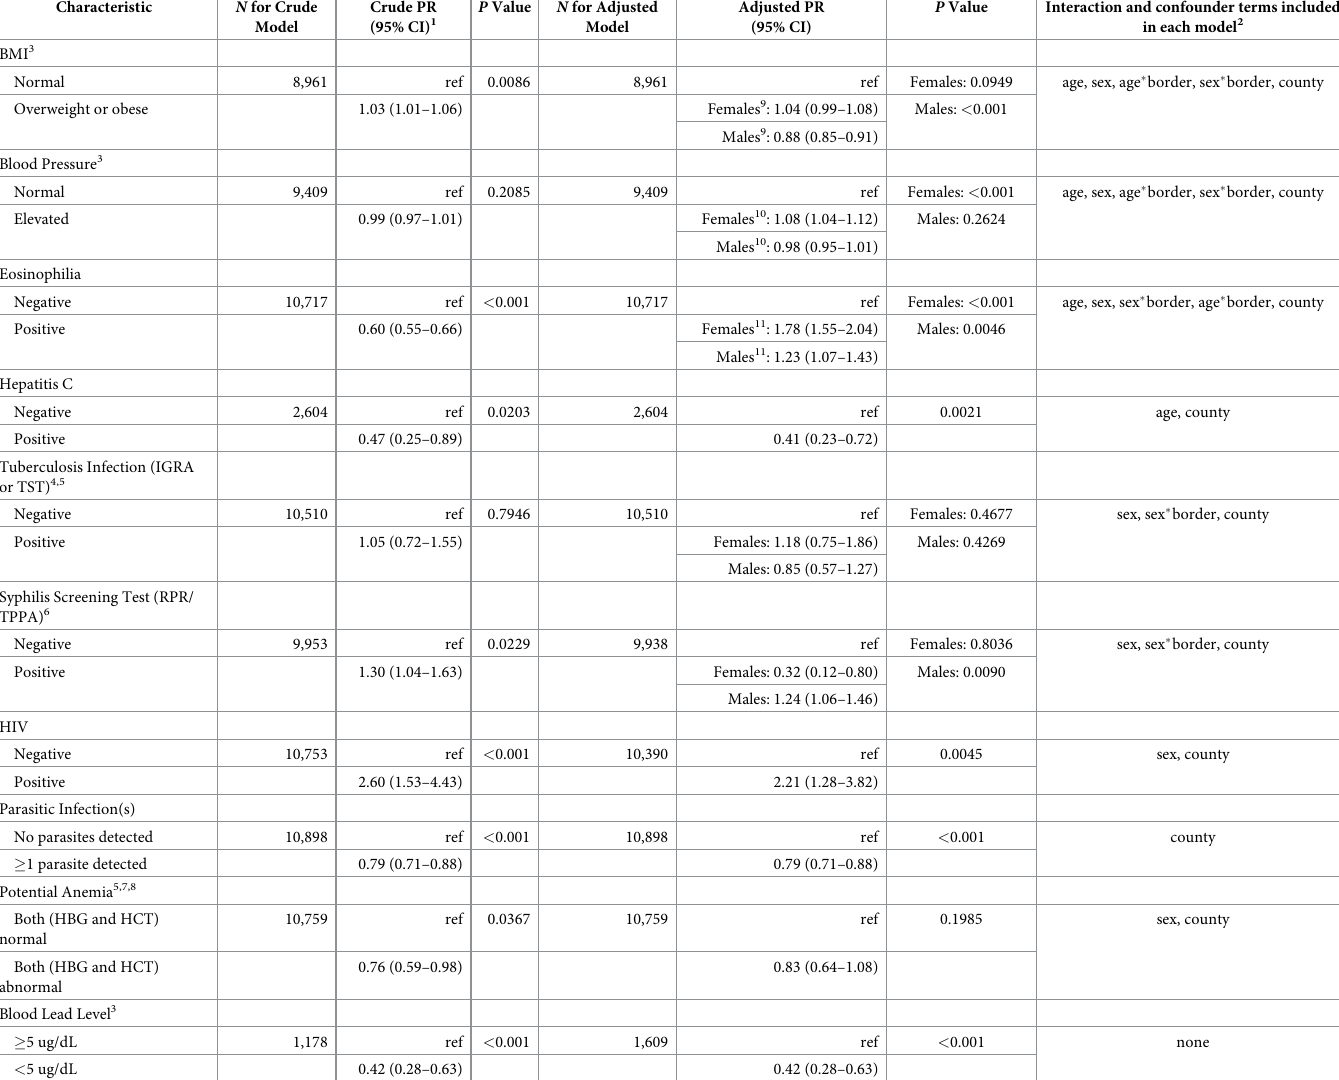
Table 3. Crude and adjusted PR of domestic medical screening status, Cubans in Texas who were paroled into the US at the border versus those who obtained refu- gee/Cuban entrant status in Cuba (reference), 2010–2015.